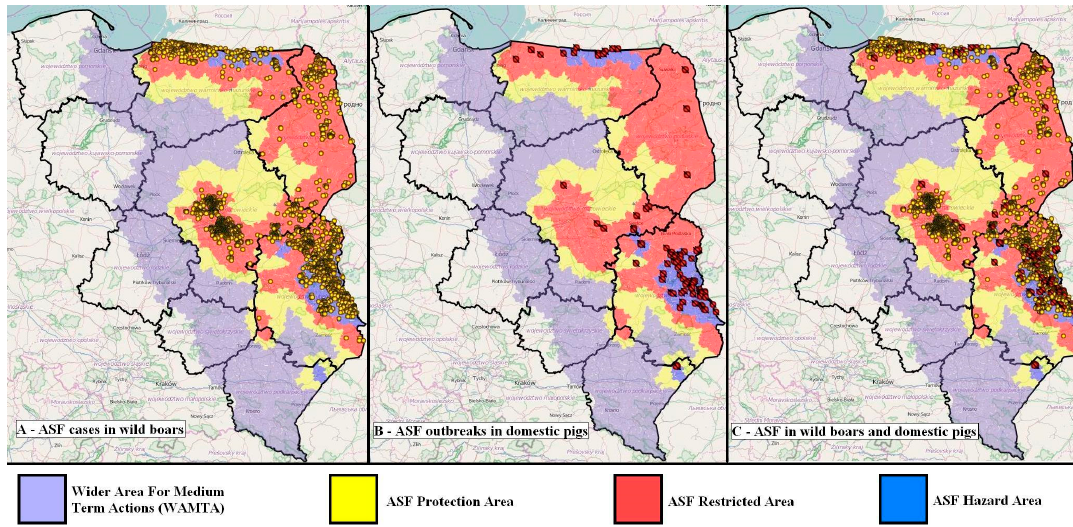
Figure 5. ASFV areas in Poland with a view of four infected voivodeships (December 2018). Adapted from [40] (with the authors’ own elaboration).